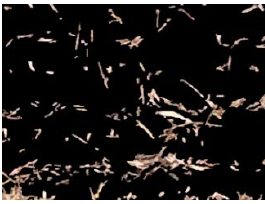
Figure 9. Manual segmentation of straw.